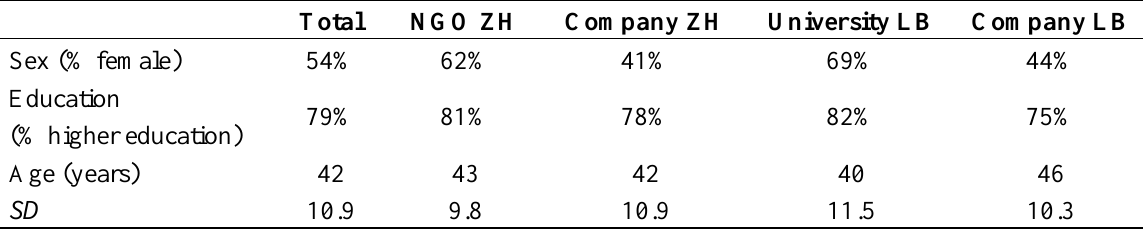
Table 1. Sample characteristics by